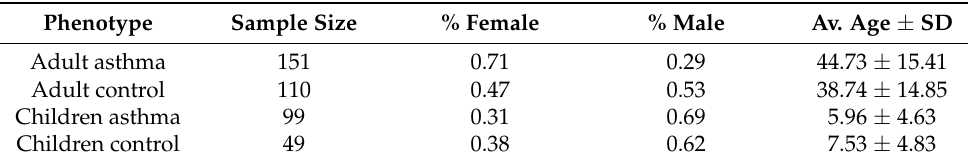
Table 1. Characteristics of the study population.